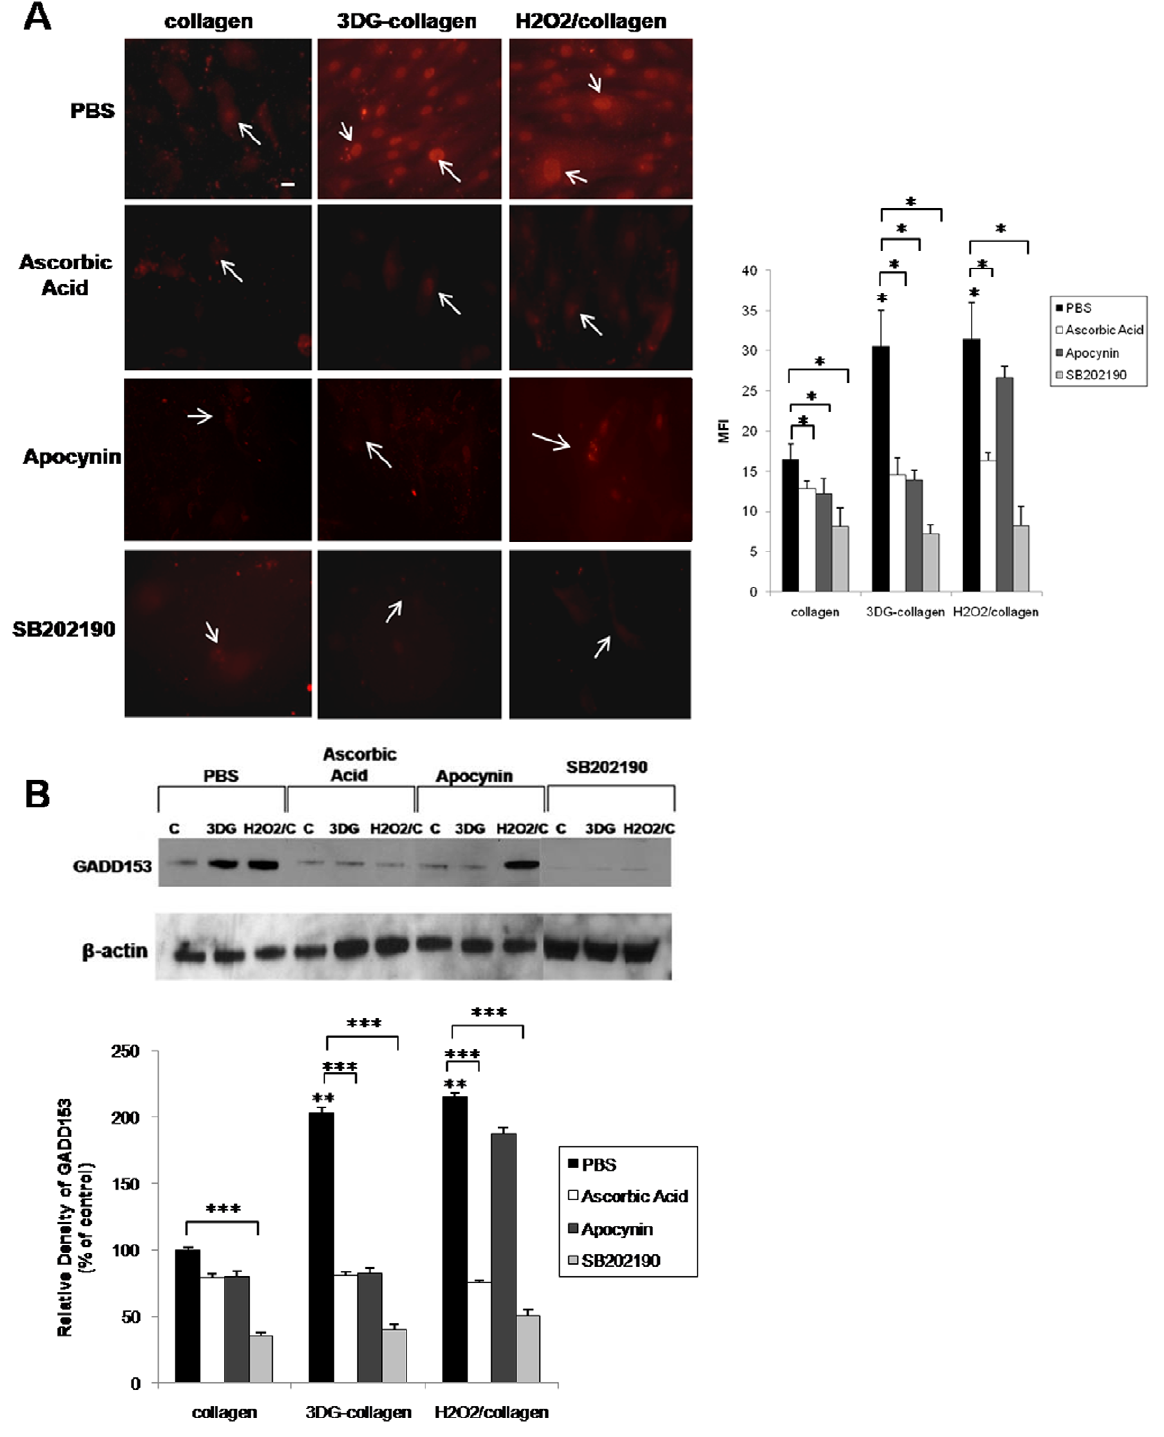
Figure 6. Inhibition of ROS, and p38 MAPK abrogates GADD153 expression in fibroblasts cultured on 3DG-collagen. Fibroblasts were pretreated with 100 m g/mL of ascorbic acid, 1 mM apocynin, or 10 m M SB202190 for 1 h, and cultured on native collagen, 1 mM 3DG-collagen or treated with 50 m M H 2 O 2 for 24 h. A , Fibroblasts were stained and analyzed for the expression of GADD153 in the nucleus by immunofluorescence using a Cy3-conjugated secondary antibody. Representative images were taken at 40 6 magnification on an epi-fluorescence microscope, and the MFI of ten nuclei was analyzed by Image J. Bars correspond to the MFI of treated fibroblasts. Arrows indicate nuclei containing GADD153. Scale bar represents 10 m m. B , Western blot for the expression of GADD153 in whole cell lysates. b -actin was used as a loading control. The bars correspond to the densitometric value of GADD153 after normalization for b -actin. All comparisons are made against collagen treated with PBS unless otherwise indicated. Data are mean 6 SD (n=3), ***P , 0.0001, **P , 0.0005, *P , 0.007.